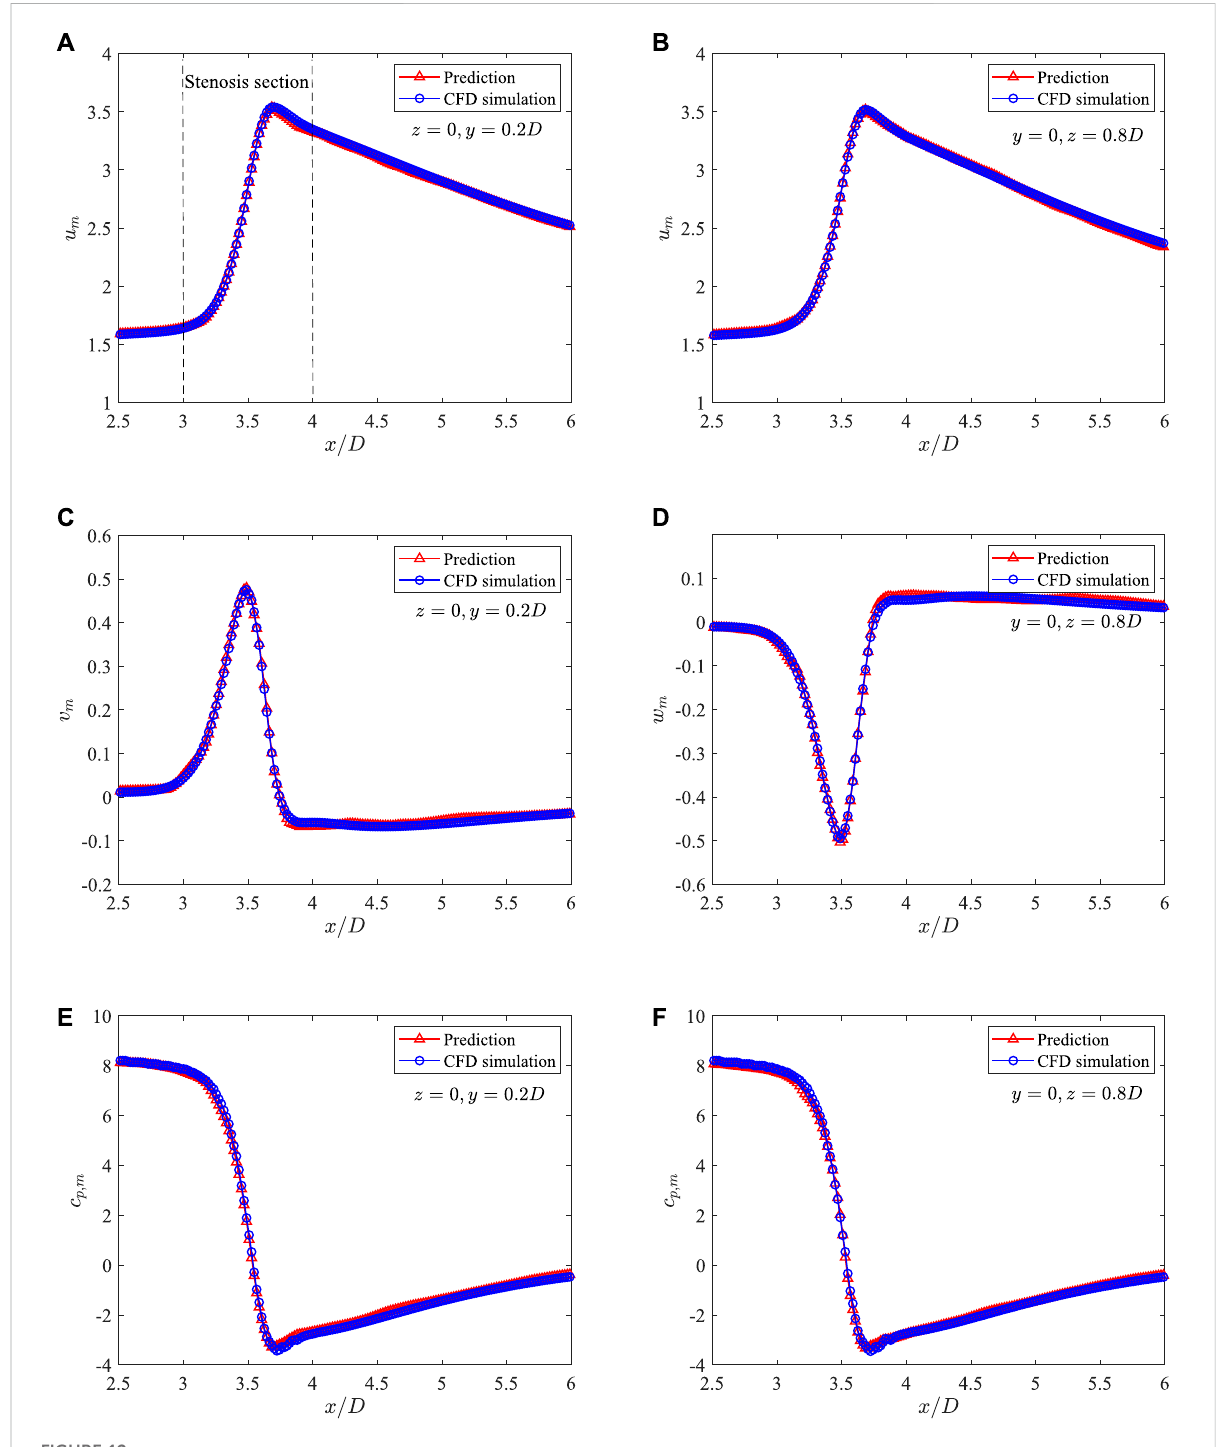
FIGURE 12 Comparisonofthemeanvelocitiesandpressurealongthestreamwisedirectionmeasuredontwolinesinthe3Daxis-symmetriccase: (A) u m at z = 0 and y = 0.2 D , (B) u m at z = 0 and y = 0.8 D , (C) v m at z = 0 and y = 0.2 D , (D) v m at z = 0 and y = 0.8 D , (E) c p z = 0 and y = 0.8 D